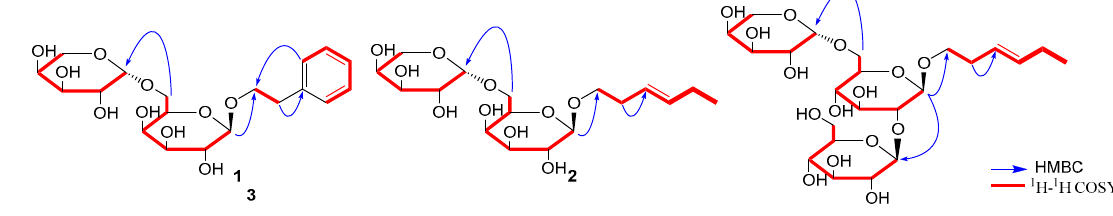
Figure 2. Key HMBC and 1 H- 1 H COSY correlations of compound 1 – 3.